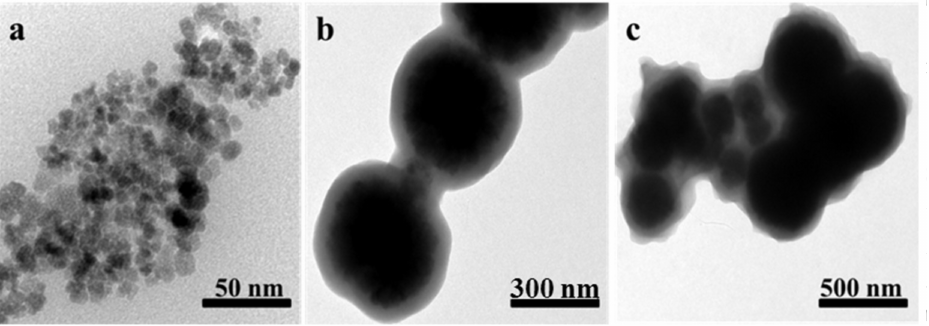
Figure 3. TEM images of ( a ) Fe 3 O 4 ; ( b ) Fe 3 O 4 @SiO 2 ; and ( c )